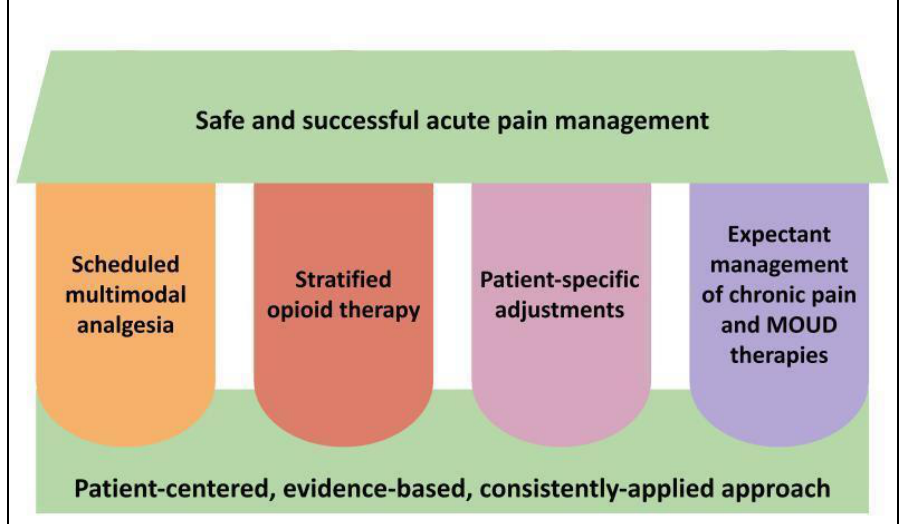
Figure 1. Key pillars of acute pain management and opioid stewardship in hospitalized patients. Legend: The four vertical pillars represent our core recommended strategies to apply to acute pain management which, when used in the context of a foundational approach as represented at the bottom of the figure, should support the desired outcome at the top of the figure. MOUD = medications for opioid use disorder.